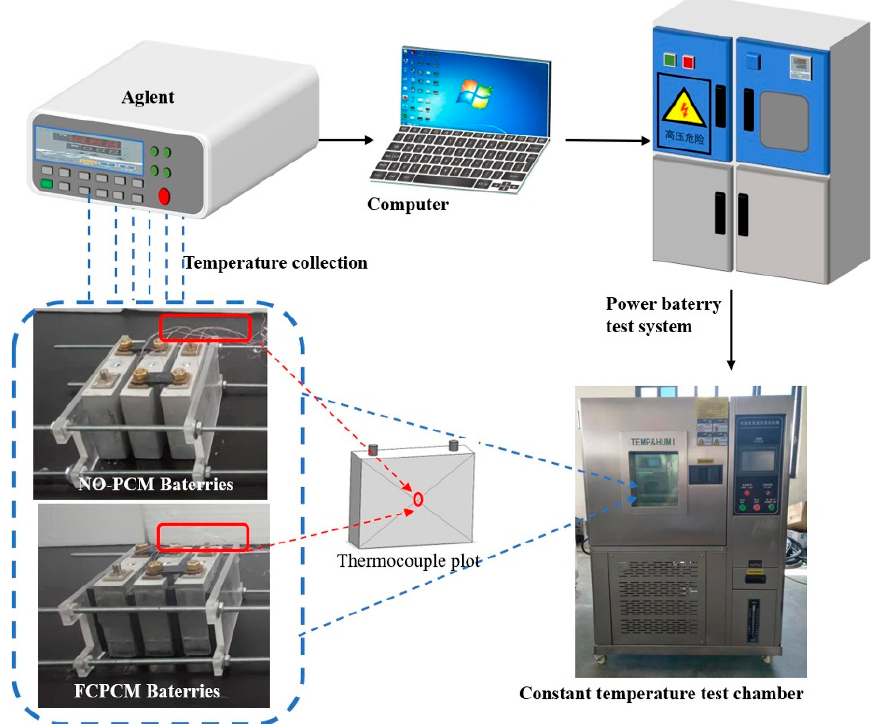
9 of 49 Figure 4. The preparation procedure of the Flexible Composite PCM (FCPCM) [35]. Reproduced with permission from Elsevier. The testing platform described in [35] is presented in Figure 5. The battery module